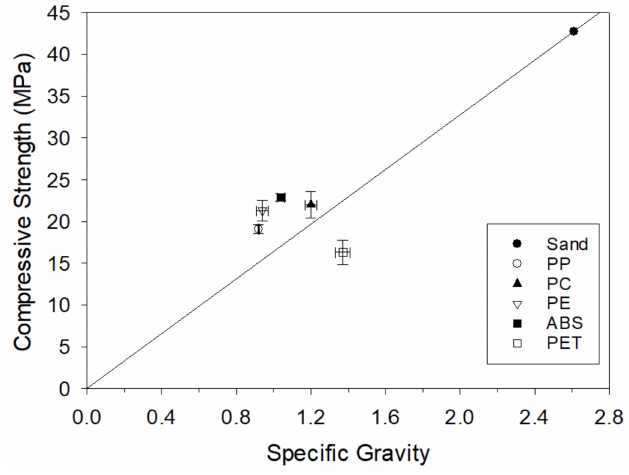
Figure 21. Density–stress relationship in cementitious composites by plastic aggregate type.